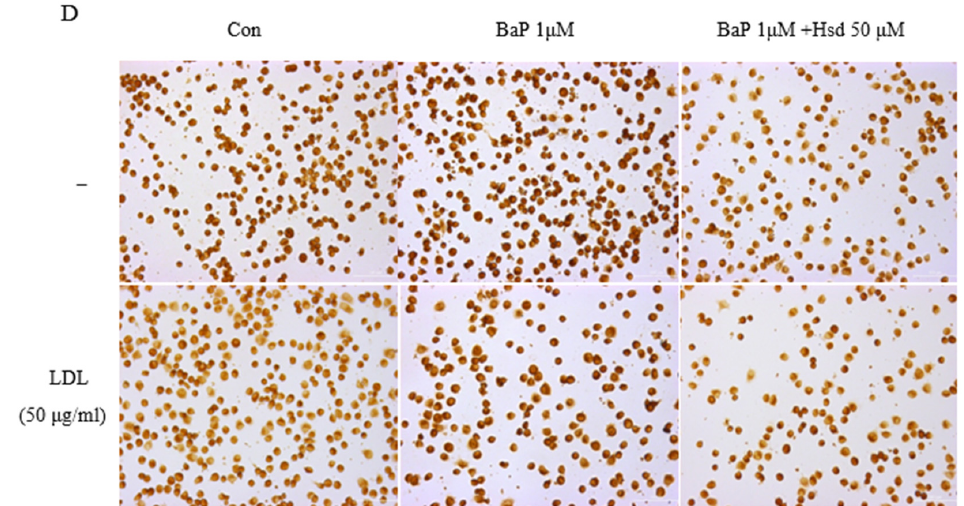
Figure 3. Anti-inflammatory effect of Hesperidin in EA.hy926 induced by BaP. ( A ) Representative Immunofluorescence of interleukin-1 β (IL-1 β ) level in EA.hy926 ( n = 3 per group). ( B ) mRNA levels of IL-1 β in EA.hy926 ( n = 3 per group). ** p < 0.01 vs. normal control group, # p < 0.05, vs. BaP control group. ( C ) mRNA levels of IL-1 β in EA.hy926( n = 3 per group). ** p < 0.01 vs.LDL group, # p < 0.05, vs. LDL + BaP group. ( D ) Representative immunocytochemistry of TNF- α level in EA.hy926. ( n = 3 per group, Scale bars, 100 μ m). The data are presented as means ± SD ( n = 3) and were analyzed